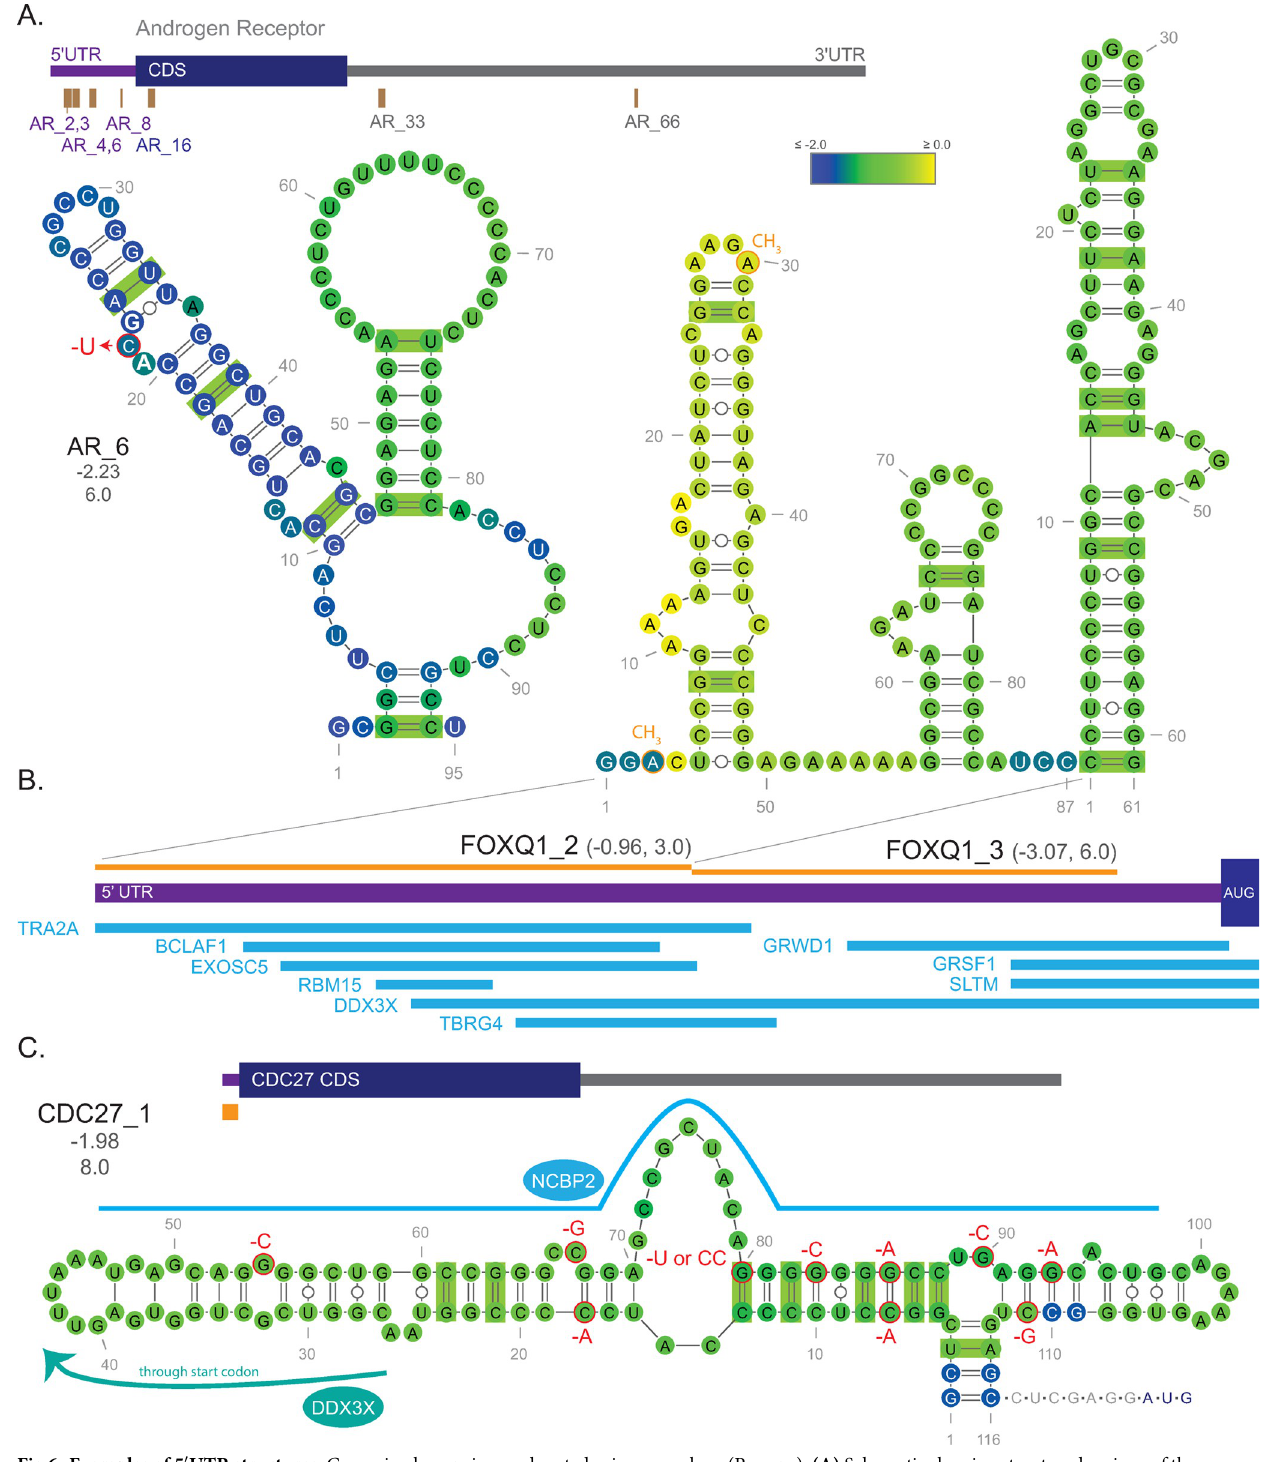
Fig 6. Examples of 5 0 UTR structures. Covarying base pairs are denoted using green bars (R-scape). (A) Schematic showing structured regions of the androgen receptor (AR) that had at least 5 covarying base pairs. Below the transcript schematic is structure 6; the upstream open reading frame (uORF) inducing mutation that can cause Complete Androgen Insensitivity Syndrome is shown in red. (B) Forkhead box Q1 (FOXQ1) 5 0 UTR schematic showing two adjacent structures (2 and 3) and the proteins determined to bind in these structured regions (blue) by eCLIP. C. Secondary structure of Cell division cycle 27 structure 1 extended to show the distance to the start codon. Reported COSMIC mutations are shown in red and the eCLIP binding region of